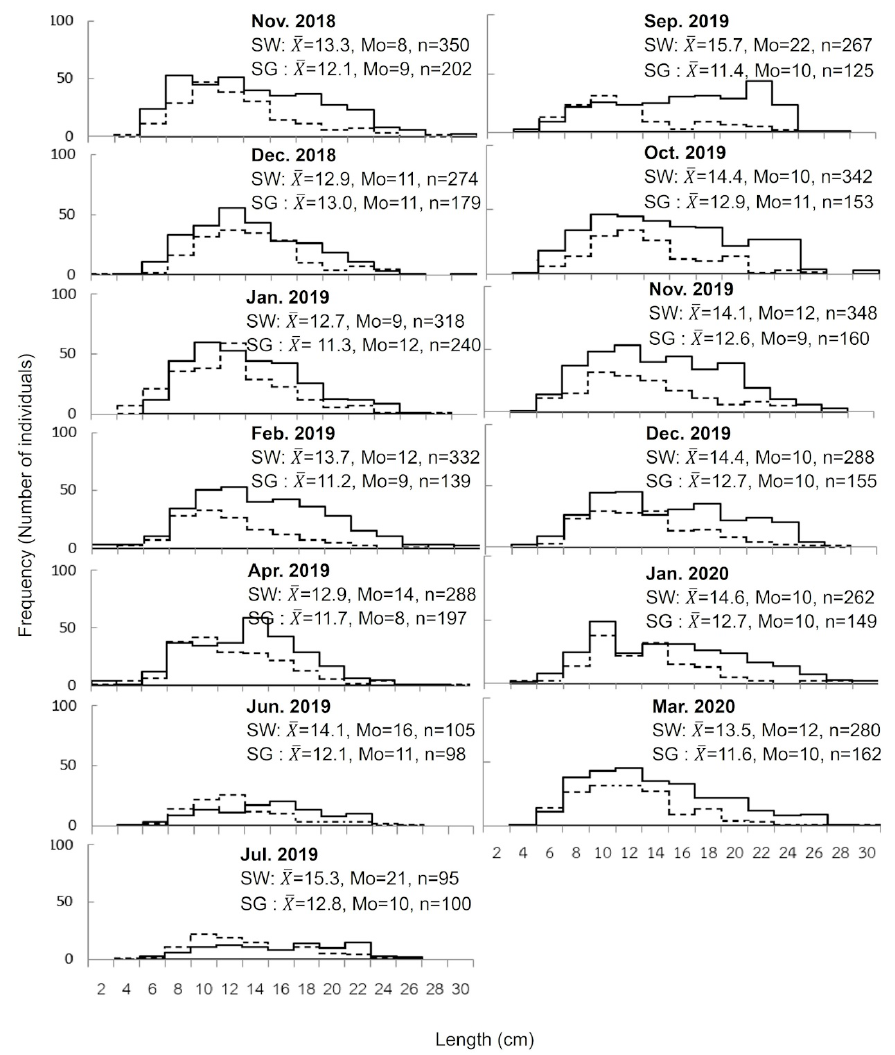
Figure 7. H. atra length-frequency distribution, sampled monthly from November 2018 to March 2020 in seagrass (dash line) and seaweed habitats (solid line).